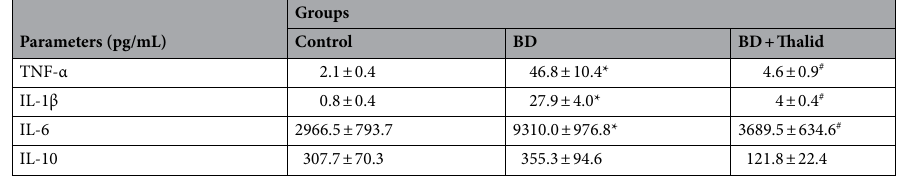
Table 3. The serum levels of TNF-α, IL-1β, IL-6, and IL-10. The samples were analysed by multiplex cytokine assay. Data are expressed as the mean ± SEM. * p < 0.05 versus Control group. # p < 0.05 versus BD group.